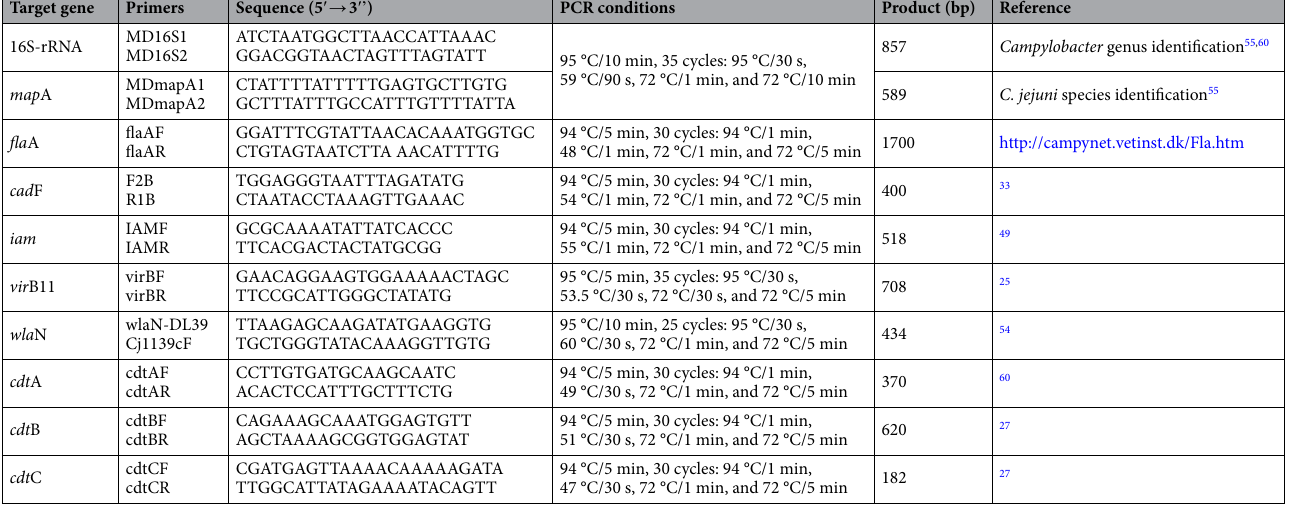
Table 5. List of primers and PCR conditions used in this